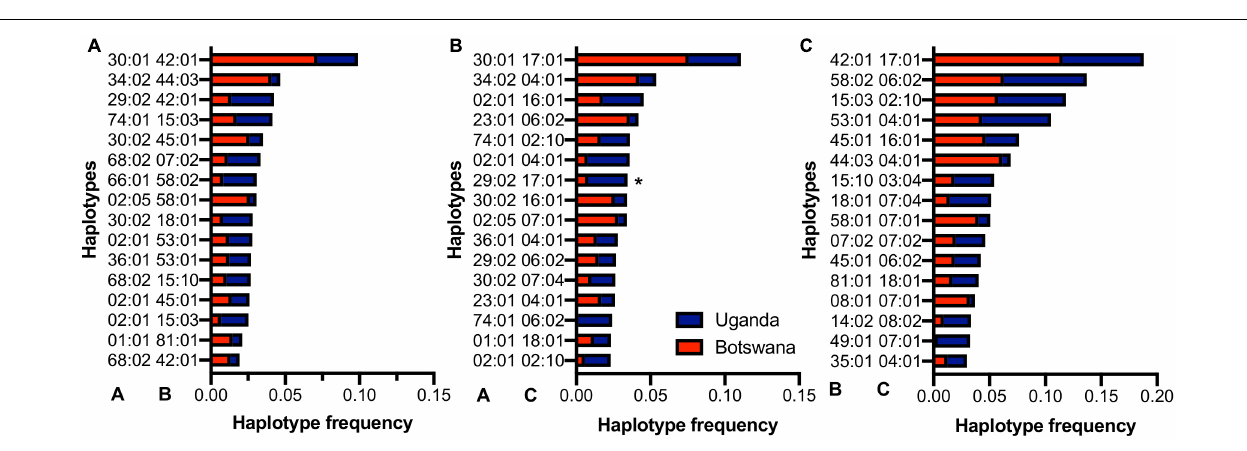
FIGURE 3 | Distribution of the commonest HLA class I (A) A–B, (B) A–C and (C) B–C haplotypes in Uganda and Botswana. *-indicates alleles that are statistically different among both